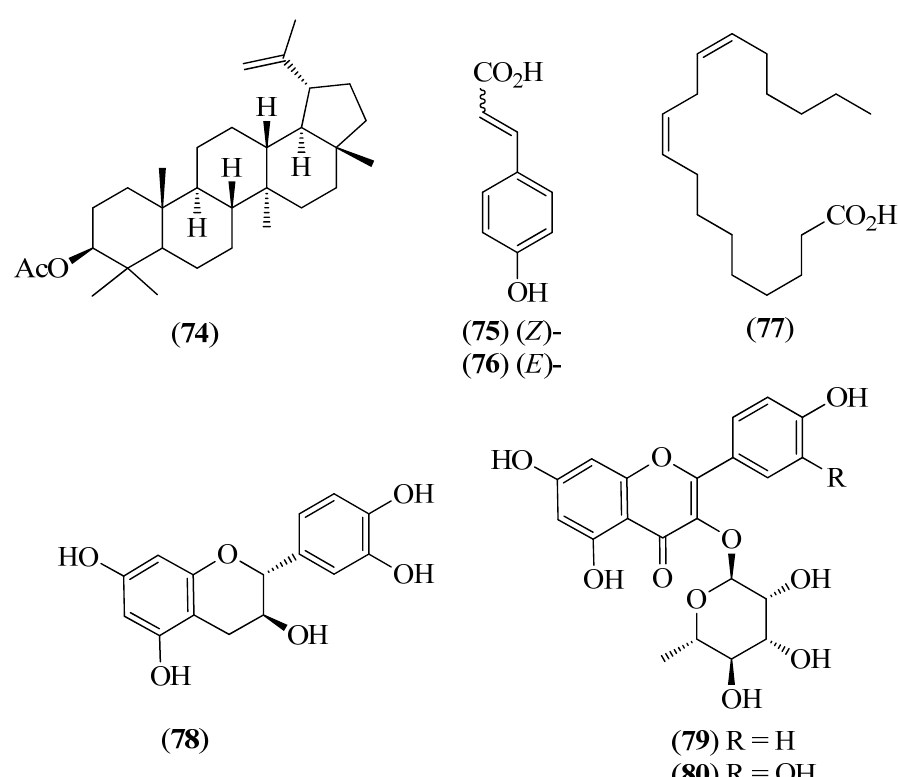
Figure 11. Structures of compounds 74 – 80 from Muehlenbeckia tamnifolia .